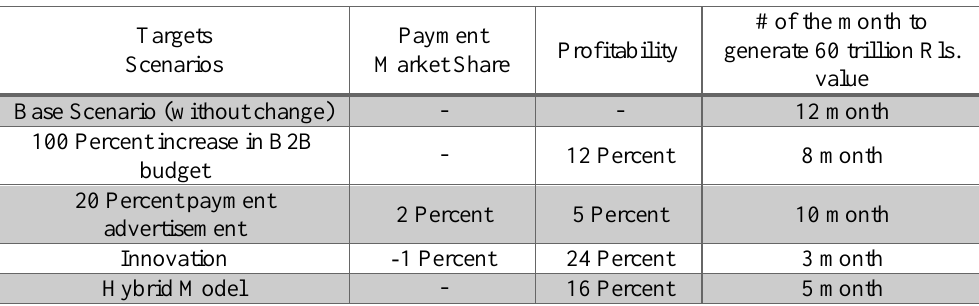
Table 4. Analyzing of